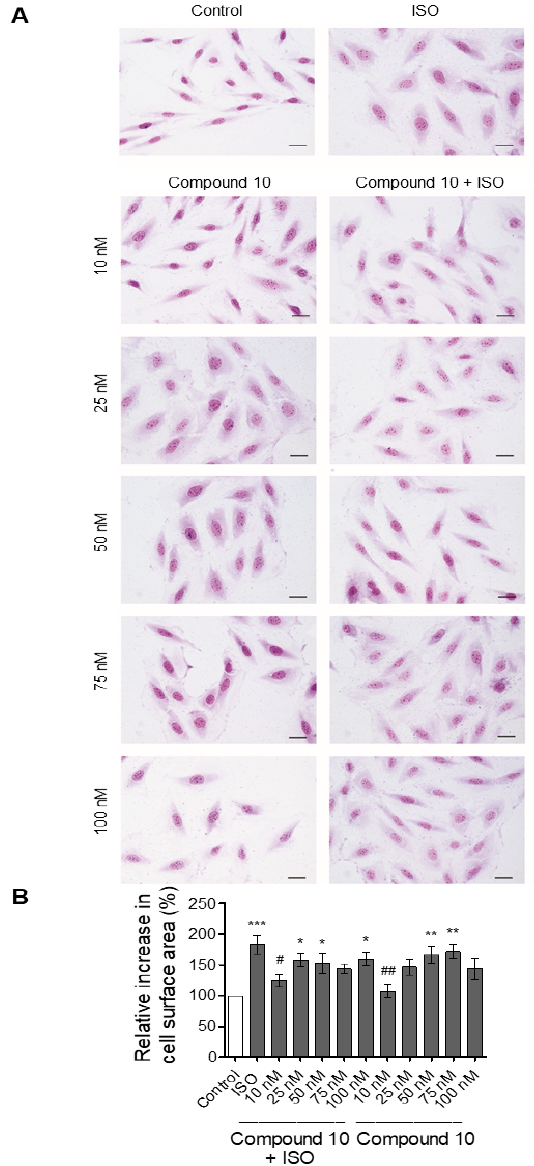
Figure 6. Effects of compound 10 on cardiomyocytes hypertrophy induced by isoproterenol (ISO) in vitro. (A) Morphological staining of H9c2 cells exposed to vehicle (indicated as Control), ISO (100 μ M), ISO + compound 10 (from 10 nM to 100 nM) and compound 10 (from 10 nM to 100 nM) for 24 h. Scale bars: 25 μ m. ( B ) Cell surface area (%) of H9c2 cells exposed to vehicle (indicated as Control), ISO (100 μ M), ISO + compound 10 (from 10 nM to 100 nM) and compound 10 (from 10 nM to 100 nM) for 24 h. Data are expressed as mean ± SEM derived from two independent measurements for each group. p < 0.05 (*); p < 0.01 (**); p < 0.001 (***) vs. Control group; p < 0.05 (#); p < 0.01 (##) vs. ISO group (one-way ANOVA and Newman-Keuls multiple comparison test).